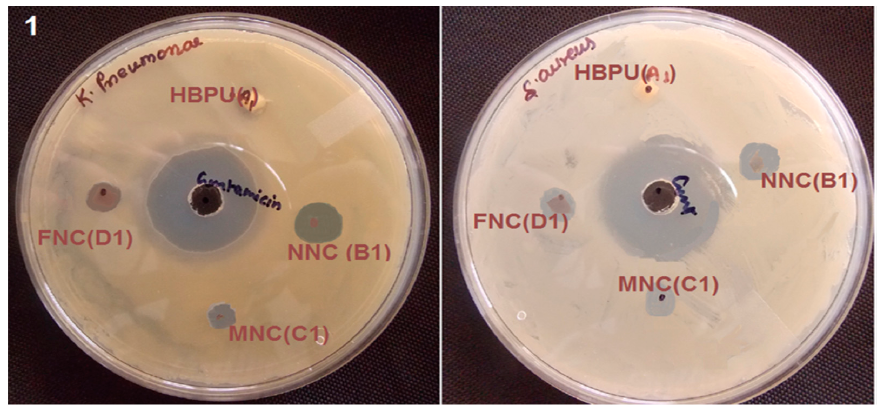
Figure 14. Inhibition zone showing the antibacterial activity against K. pneumonia and S. aureus for the neat polyurethane derived from the oil (HBPU), NNC, FNC, and MNC. The nomenclature is indicated in Figure 7. Reprinted from [49], copyright 2014, with permission from the Royal Society of Chemistry.